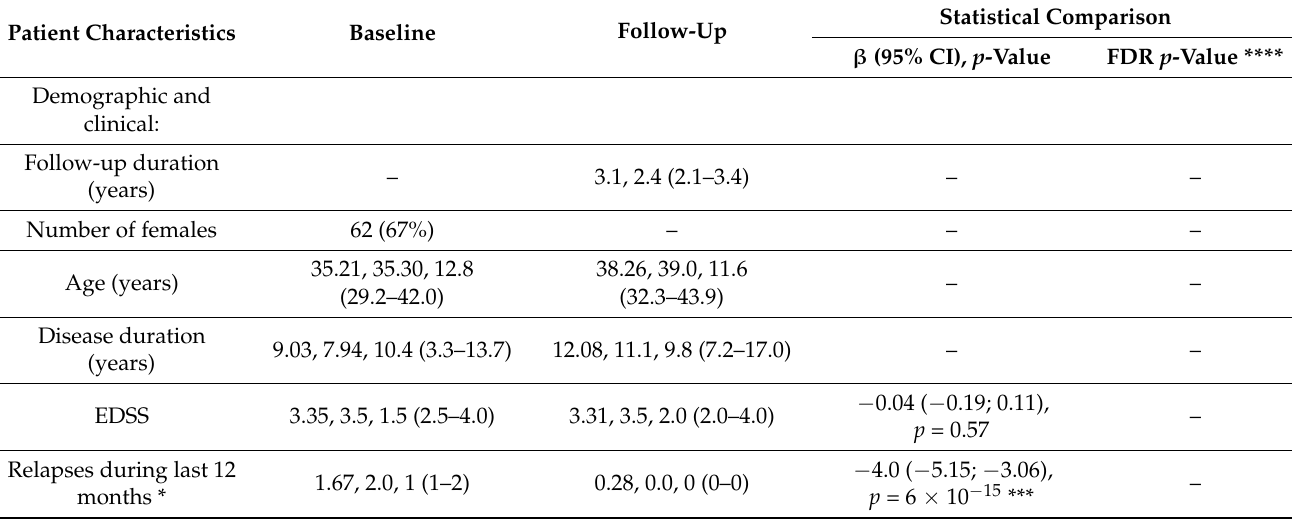
Table 1. Baseline and follow-up characteristics of the 93 relapsing-remitting MS patients treated with natalizumab. Patient